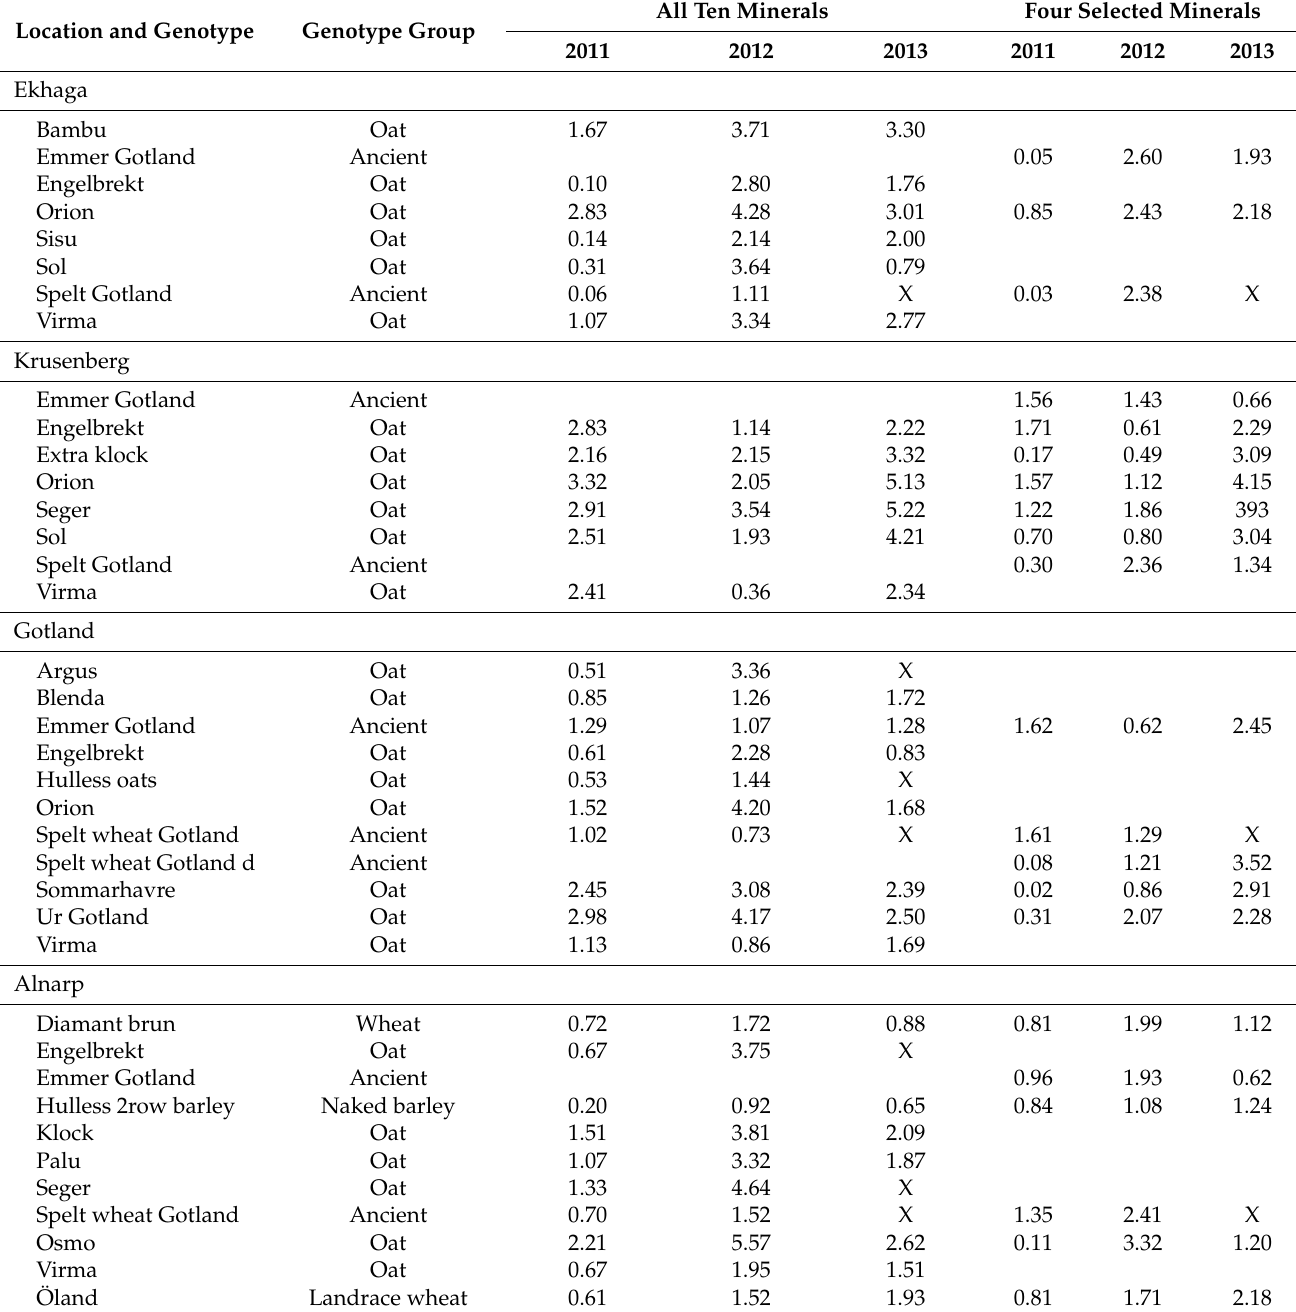
Table 6. PC1 values from each cultivation location for genotypes with positive PC1 values in all years for all ten minerals evaluated and for four (Zn, Fe, Mg and Cu) minerals of specific nutritional importance